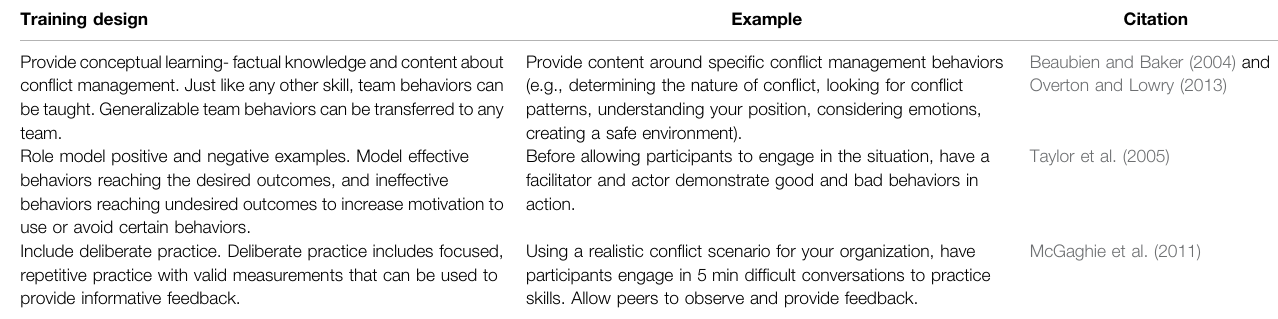
TABLE 2 | Simulation best